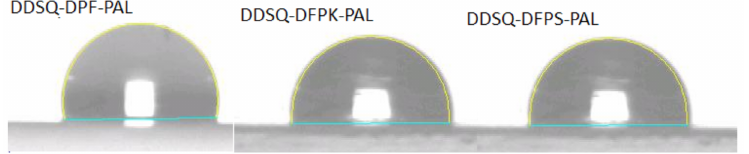
Figure 9. Water contact angles of DDSQ-DFPXs-PAL films after curing.